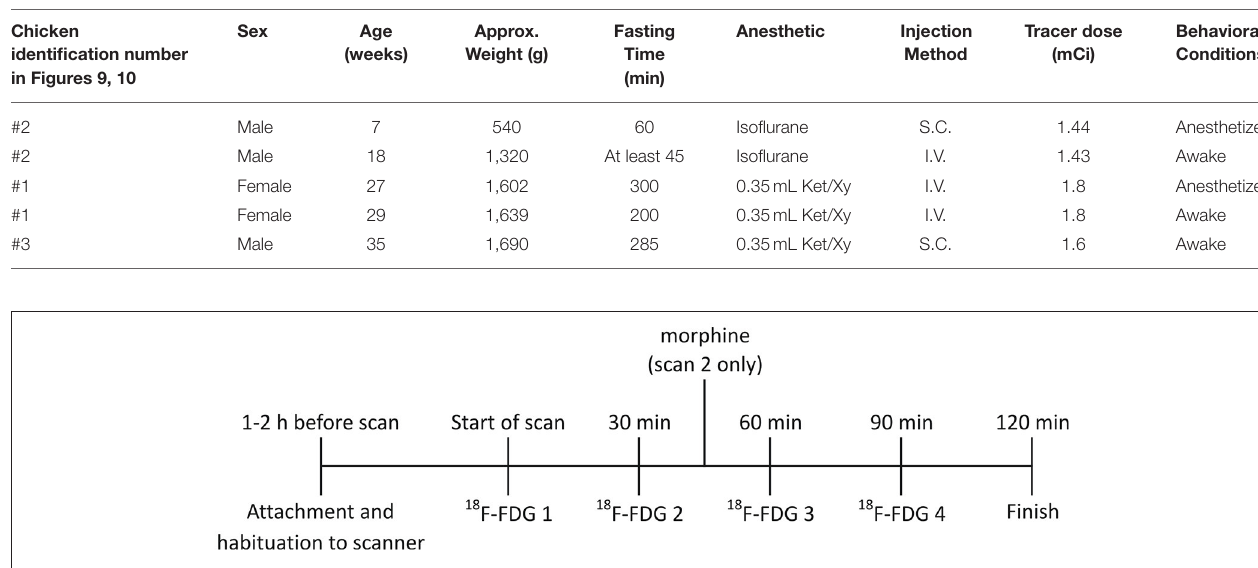
FIGURE 1 | Timeline for RatCAP studies. The rat was attached to the RatCAP 1–2h before the start of the scan for acclimation to the scanner and the open field. The start of the scan coincided with the first 18 F-FDG injection. 18 F-FDG was injected 4 times, approximately 30min apart. In scan 2, morphine (3 mg/kg; i.v.) was also administered approximately 15min after the second 18 F-FDG